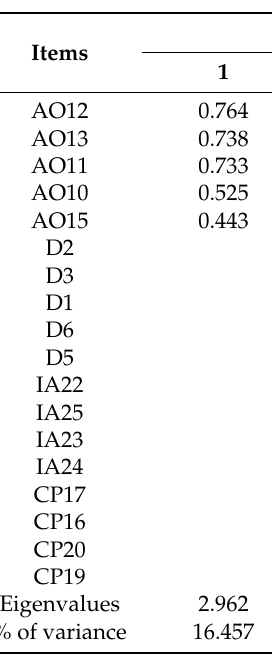
Table 5. Factor loading from the principal axis factor analysis with varimax rotation for a four-factor solution and adapted PMPUS ( n =